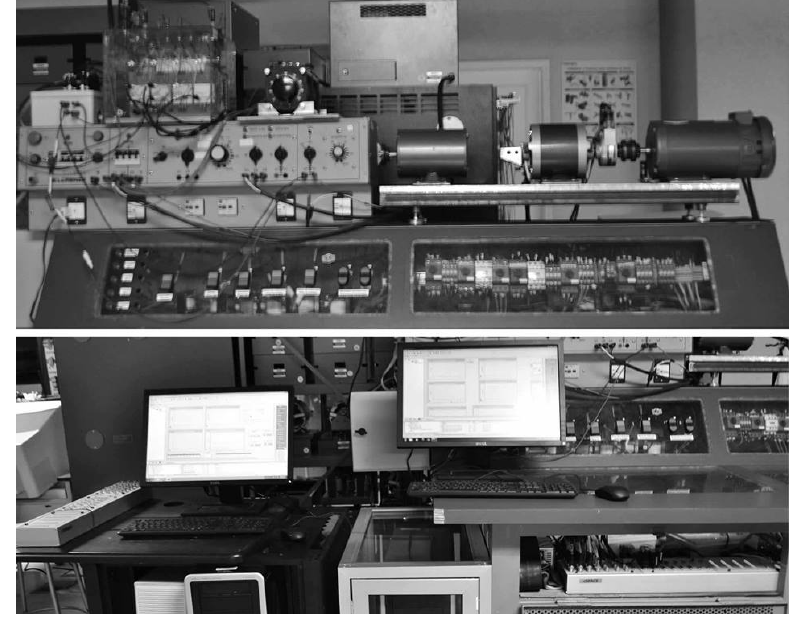
Figure 2. DC motor–AC induction generator group test